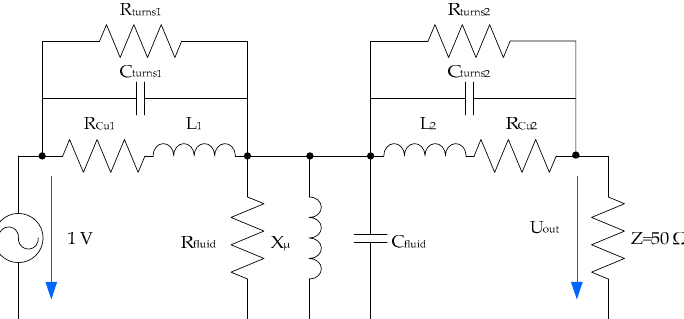
Figure 6. Electrical equivalent circuit used for simulations.